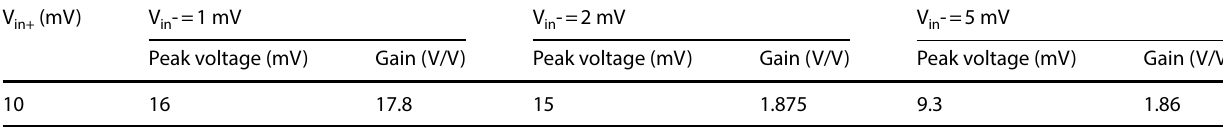
Table 2 Differential input voltages used for the designed amplifier